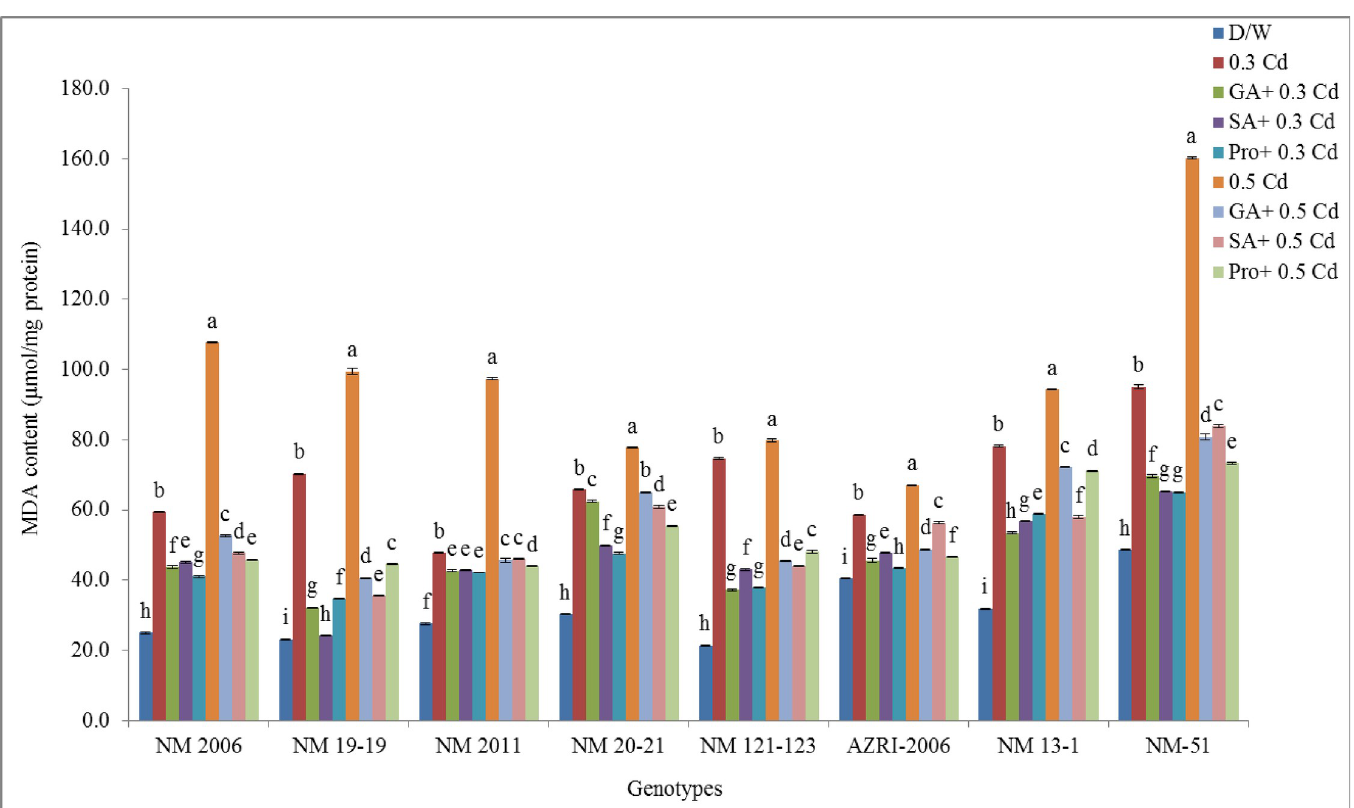
Fig 14. MDA contents of mung bean grown under Cd and pretreatments of GA 3 , SA and proline prior to Cd.